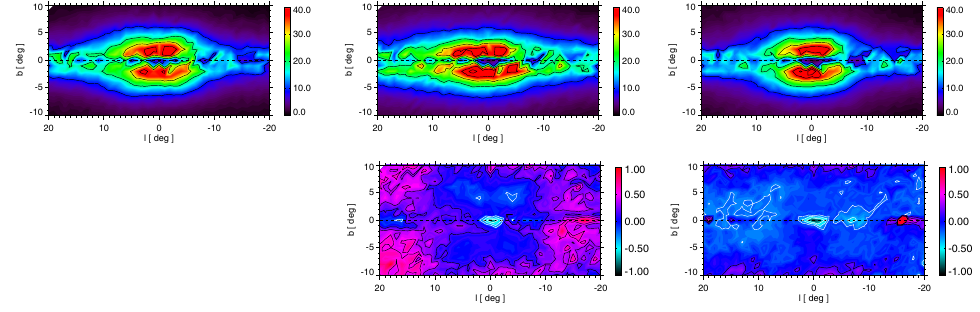
Figure 1. Star counts up to limiting magnitude K S from 2MASS data (top left) compared with 1-ellipsoid model (top middle) and its residuals (N mod -N obs )/ N obs (bottom middle), 2-ellipsoid model (top right) and its residuals (bottom right). In the residual map, contours are drawn at intervals of 20% model overestimate (black) and 20% model underestimate (white). The 2-ellipsoid model gives a much better fit to the dat counts over a wide area. Near the Galactic centre the nuclear bar population is missing in the model and thus appears in the